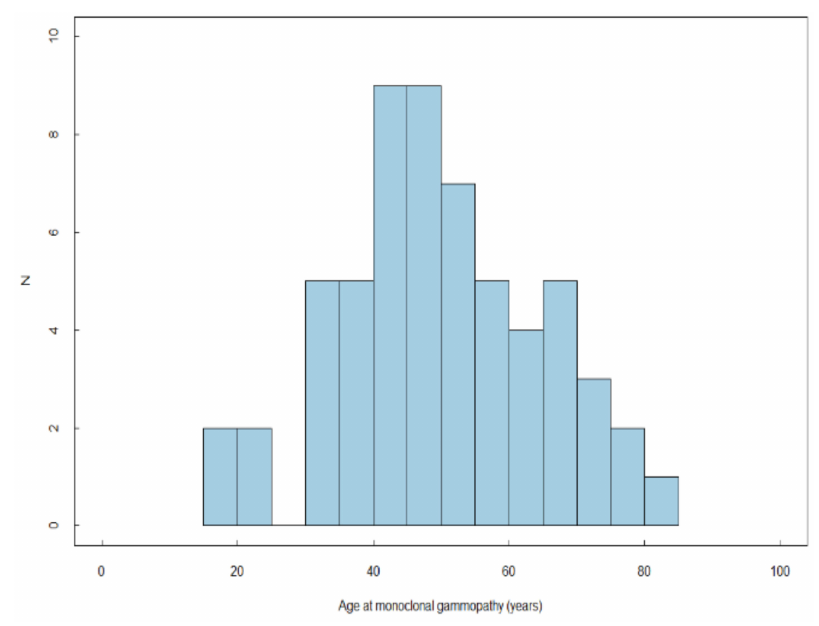
Figure A2. Age at monoclonal gammopathy diagnosis ( n =